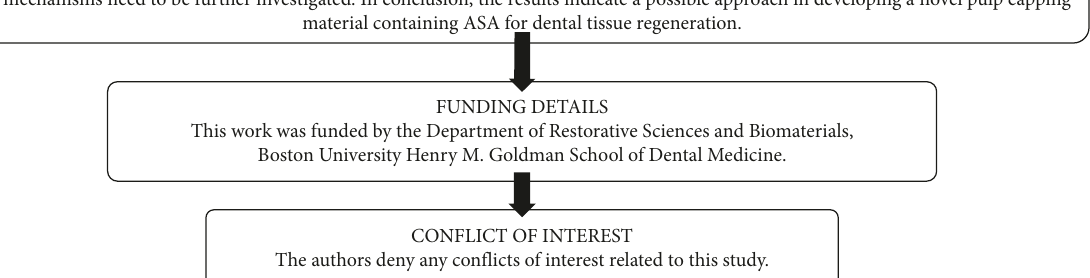
Figure 1: The Preferred Reporting Items for Laboratory studies in Endodontology (PRILE) 2021 flowchart summarizes the key steps in the reporting of a laboratory